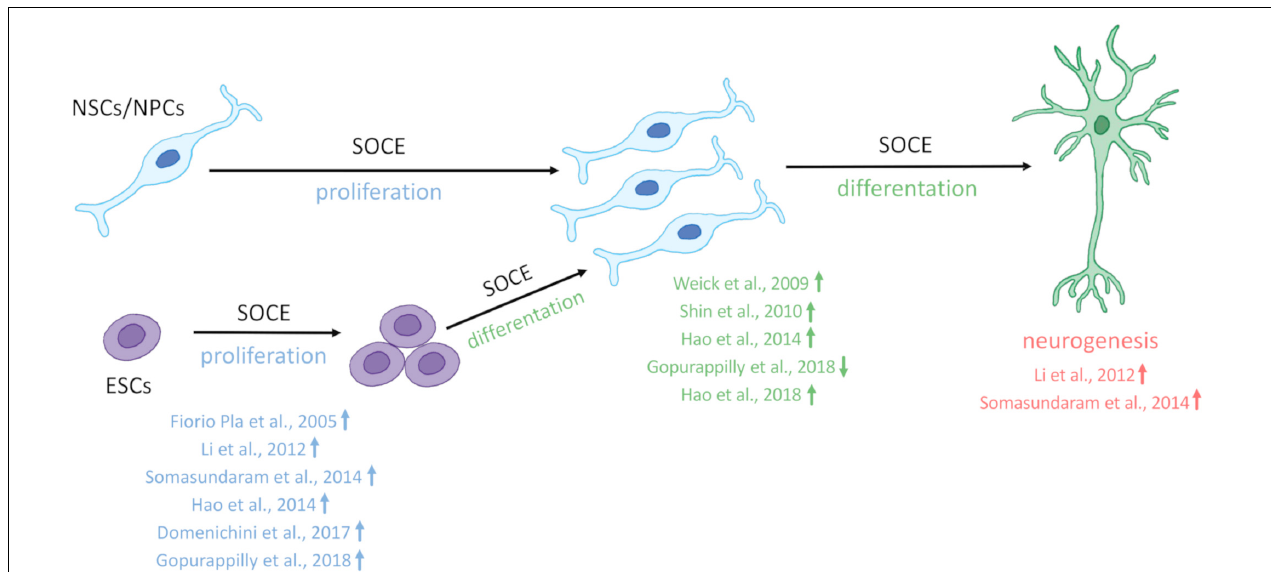
FIGURE 1 | SOCE regulates neural stem cell physiology. Store-operated Ca 2 + entry (SOCE) and its molecular components positively regulate the proliferation of embryonic stem cells (ESCs) and neural stem cell (NSCs)/neural progenitor cells (NPCs), differentiation of ECSs, and NSCs/NPCs as well as neurogenesis. References that correspond to respective discoveries are shown in the figure. The upward arrows indicate that SOCE and its molecular players positively regulate proliferation, differentiation, and neurogenesis. Compared with other studies Gopurappilly et al. (2018) (reference indicated in the figure by a down arrow) detected a decrease in NSC